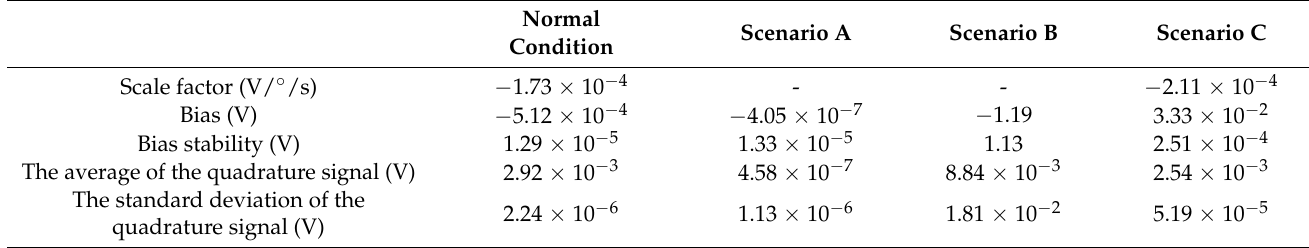
Table 1. The experimental results of the electric malfunction imitated test.